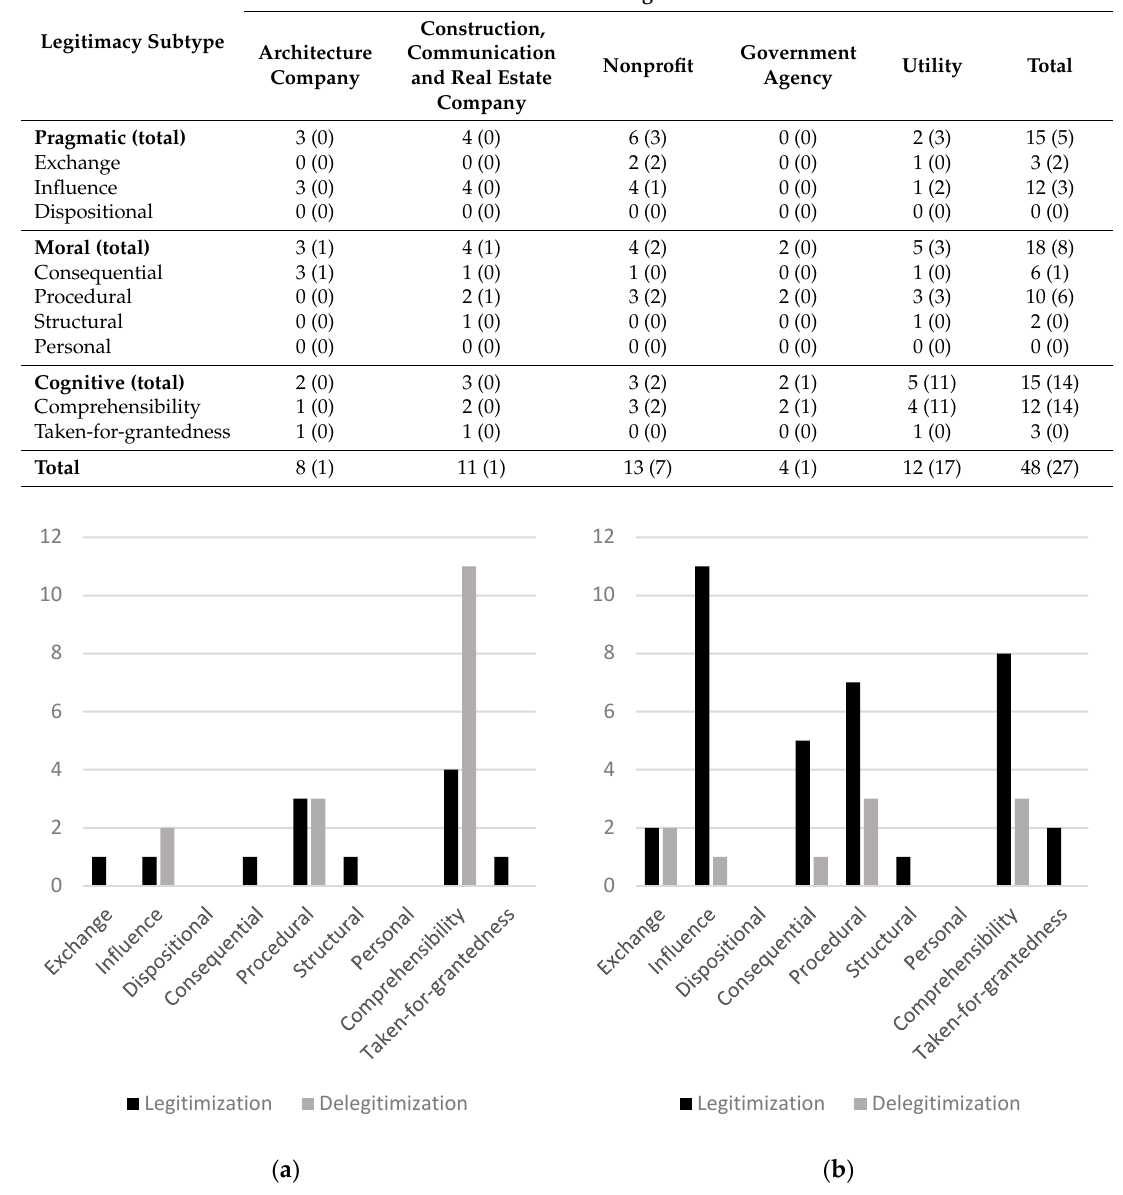
Figure 2. Frequency of legitimacy subtypes used to (de)legitimize the project of providing water and sanitation to displaced persons by: ( a ) the utility interviewees, and ( b ) all the remaining interviewees.